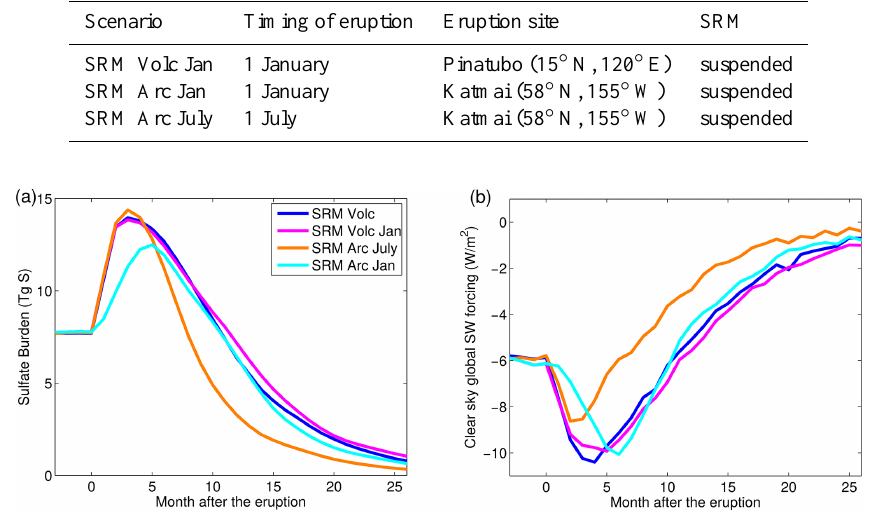
Figure B2. (a) Stratospheric sulfate burden and (b) global mean clear-sky shortwave radiative forcing after the eruption in January (blue line) and July (magenta line) and Arctic eruption in January (cyan line) and July (orange